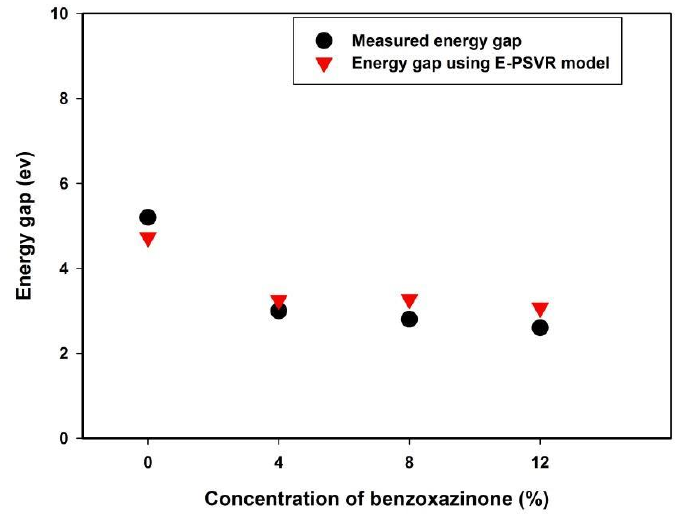
Figure 7. The effect of benzoxazinone’s incorporation on the energy gap of polyvinyl alcohol.